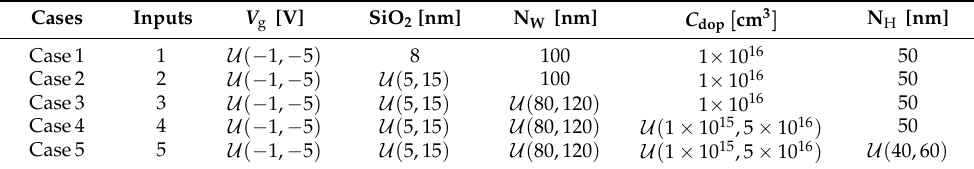
Table 2. The range of parameters used to compute the electrical current in different cases.